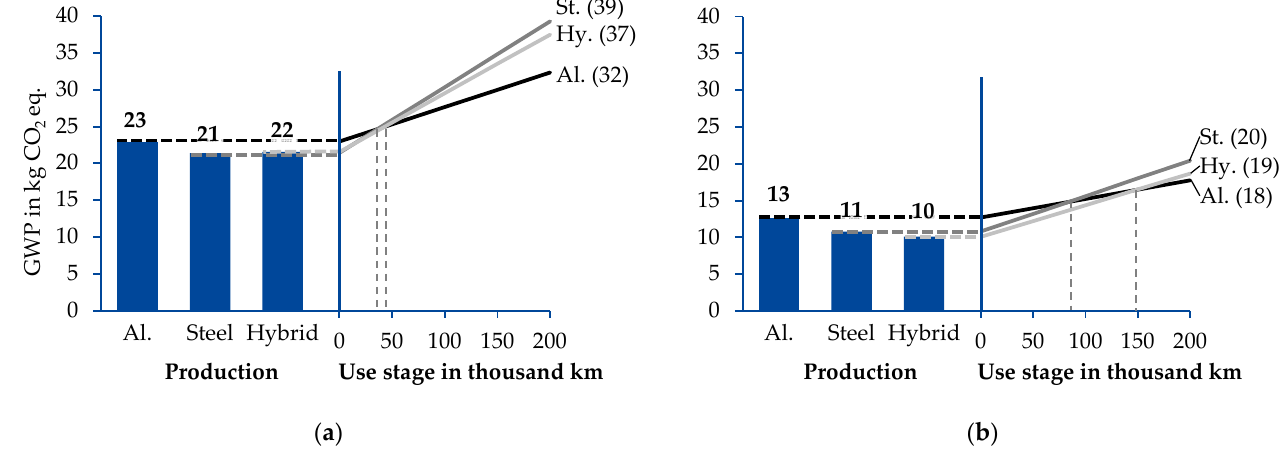
Figure 10. Production and use stage GWP of the three design alternatives: steel design (St.), hybrid design (Hy.) and aluminium design (Al.) for 2030 ( a ) and 2040 ( b ).